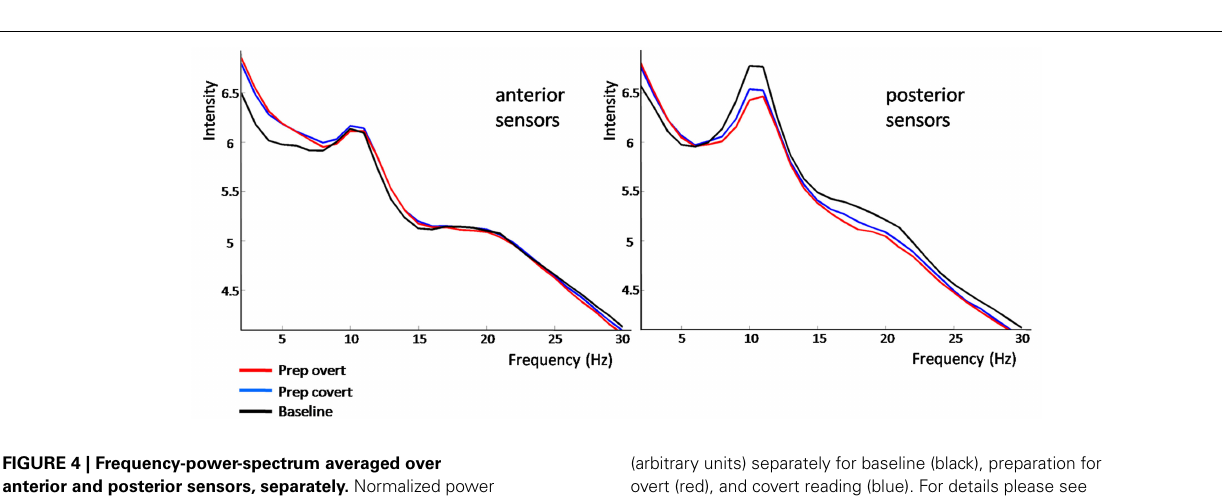
(arbitrary units) separately for baseline (black), preparation for overt (red), and covert reading (blue). For details please see Section